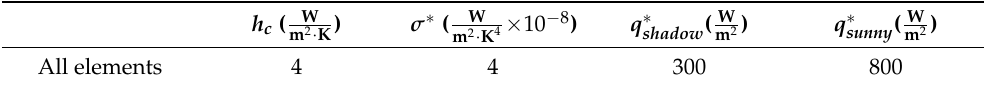
Table 3. The parameters of convection, radiation, and heat source in case of wall surface area